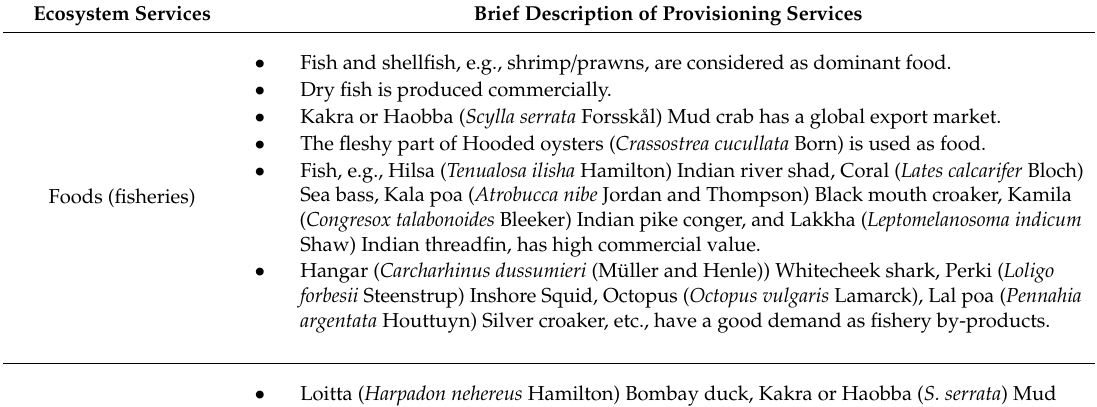
Table 4. Provisioning ecosystem services from the south-eastern coast of Bangladesh. Ecosystem Services Brief Description of Provisioning